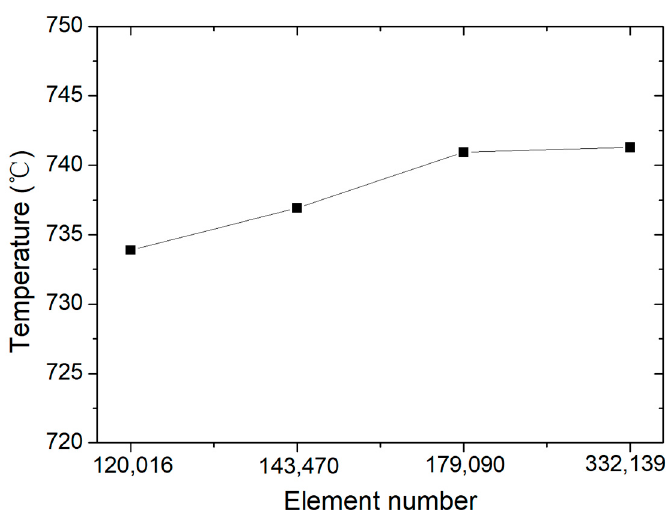
Figure 5. Mesh independence verification.